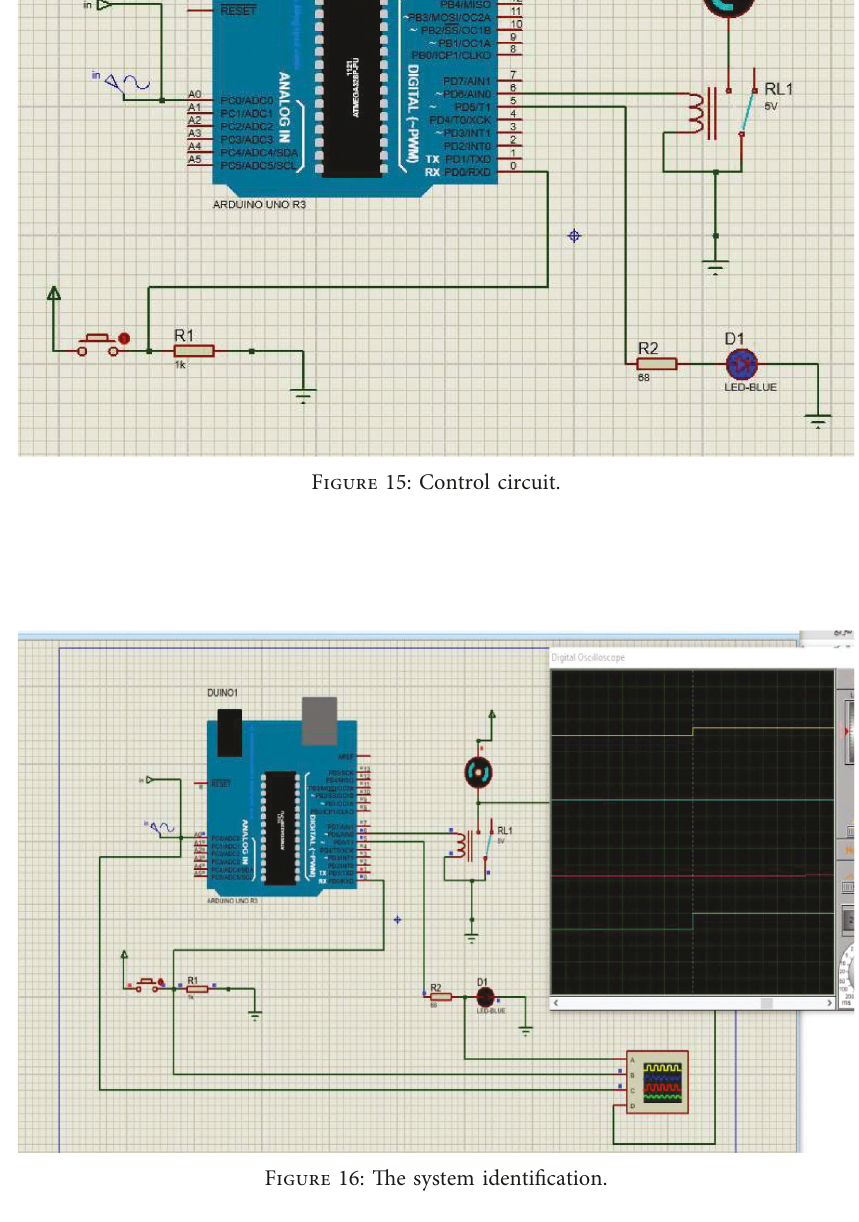
Table 3: Process sheet of the bottom body of the boat. Part No.